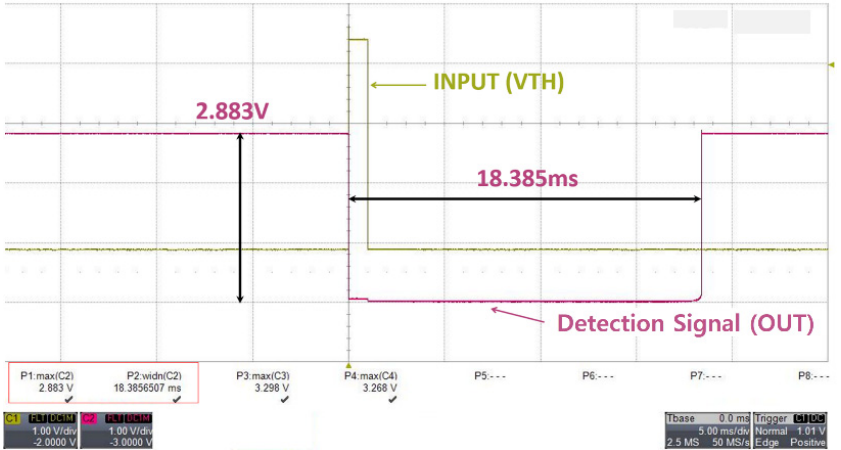
Figure 12. Functional verification measurement result of the proposed pulsed-radiation detection circuit.